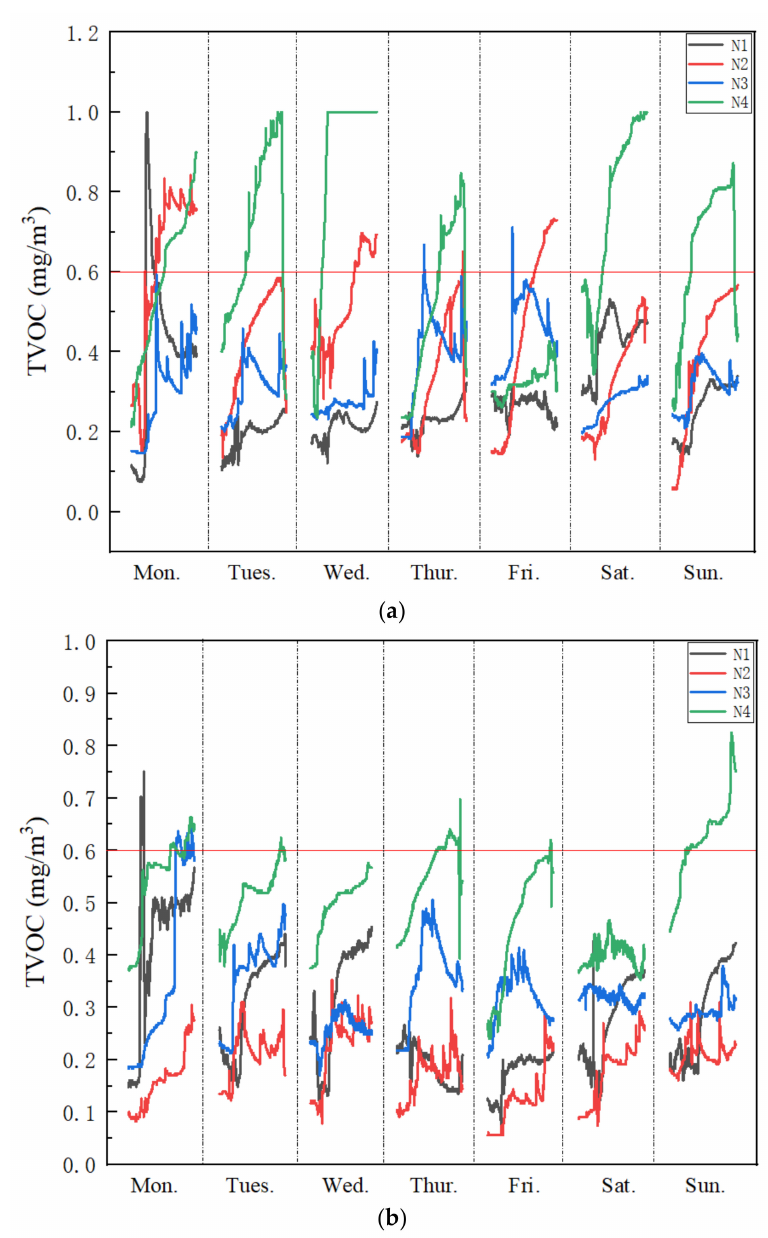
Figure 16. TVOC measurement results. ( a ) Before heating, ( b ) After